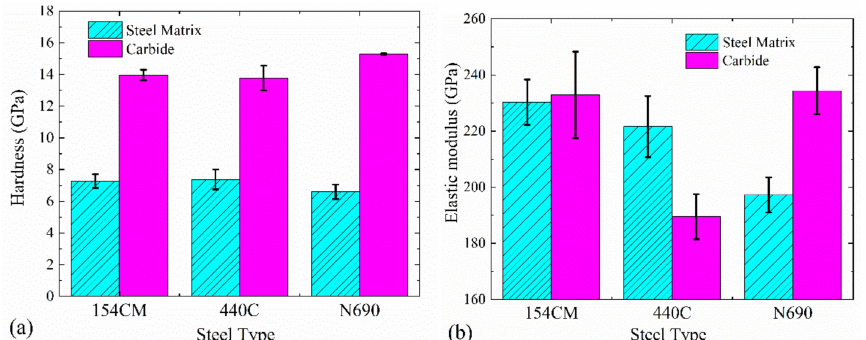
Figure 11. Comparison of hardness ( a ) and elastic modulus ( b ) of martensitic matrix and carbide phases in three stainless steels: 154CM, 440C and